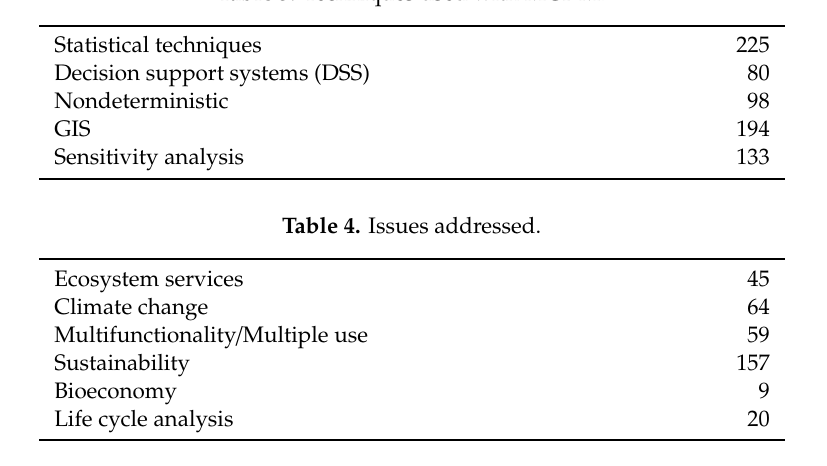
Table 3. Techniques used with MCDM.